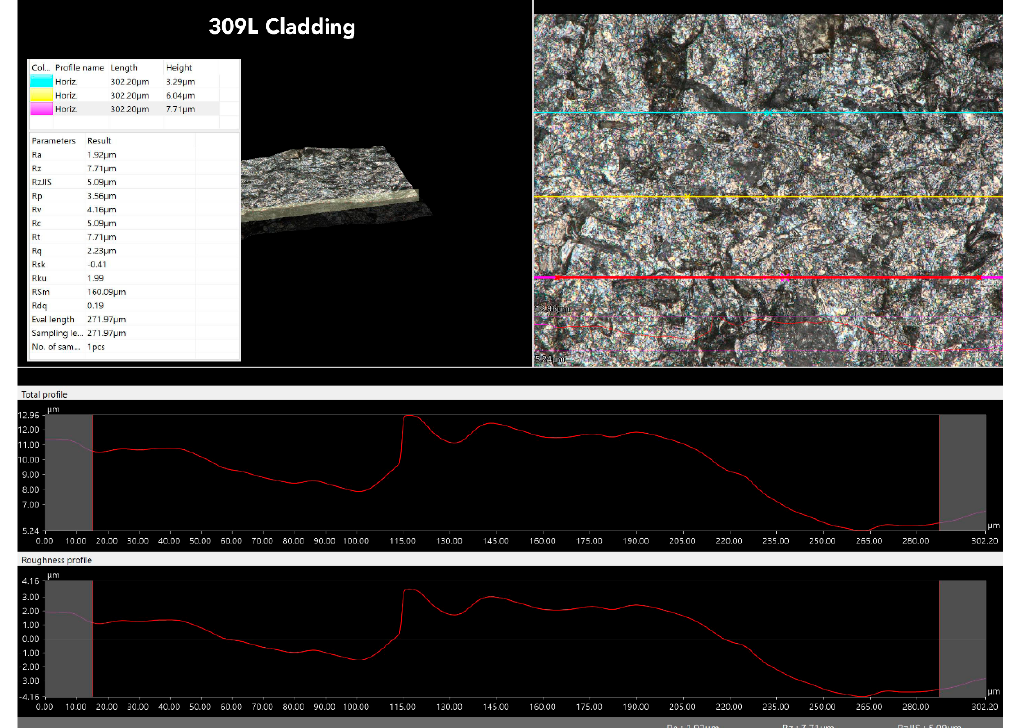
Figure 18. The measured surface roughness values of A36—A36 substrate. Coatings 2020 , 10 , x FOR PEER REVIEW